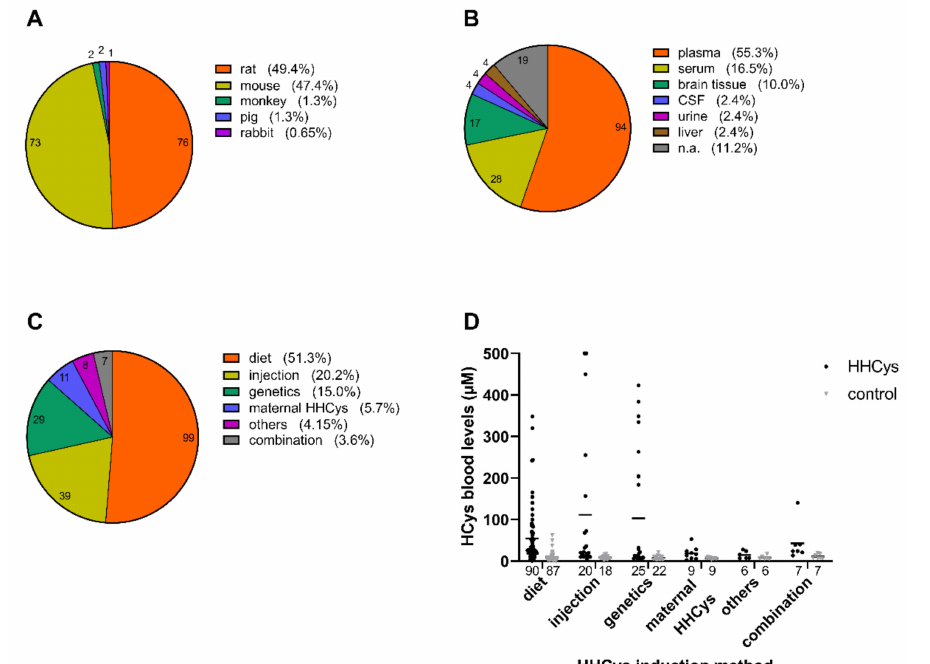
Figure 6. Average HCys levels and prevalence of different parameters, resulting from the analysis of the reviewed animal studies (numbers in the pie charts and at the bottom of the bars indicate the absolute amount of underlying studies): ( A ) animal species (154 cases in 154 studies in total); ( B ) biological matrices (170 cases in 154 studies); ( C ) HHCys induction methods (193 cases in 154 studies); ( D ) HCys elevation per induction method (every included study is considered as n = 1); since this is no meta-analysis according to the PRISMA guidelines, it should be considered semi-quantitatively; due to the large variation in individual studies, this panel should be used as a reference only; further methodological details are provided in the appendix of this review; created with GraphPad Prism 8 (San Diego, CA,